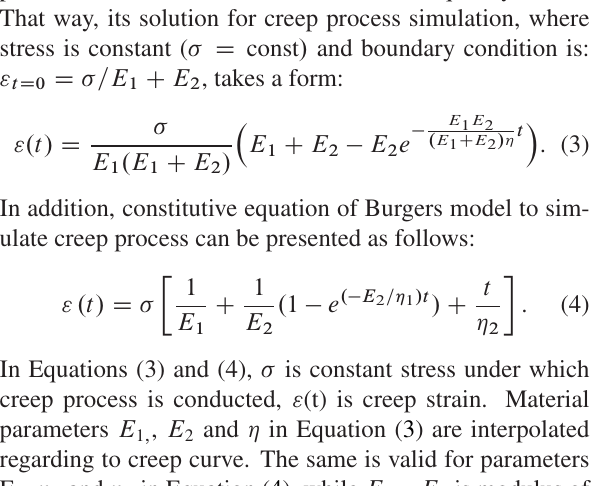
Figure 6. Experimentaly obtained and modeled creep curves: AISI 303 steel and AISI 316Ti steel (Burger’s